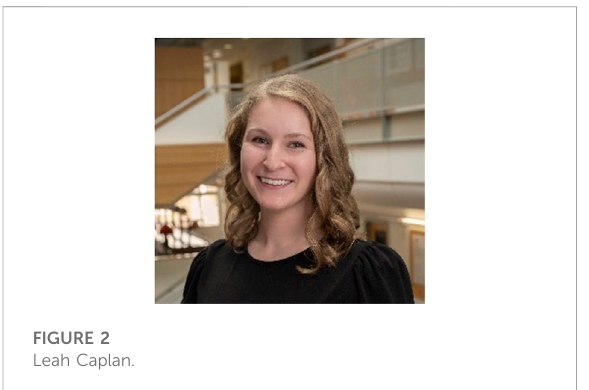
FIGURE 2 Leah Caplan.